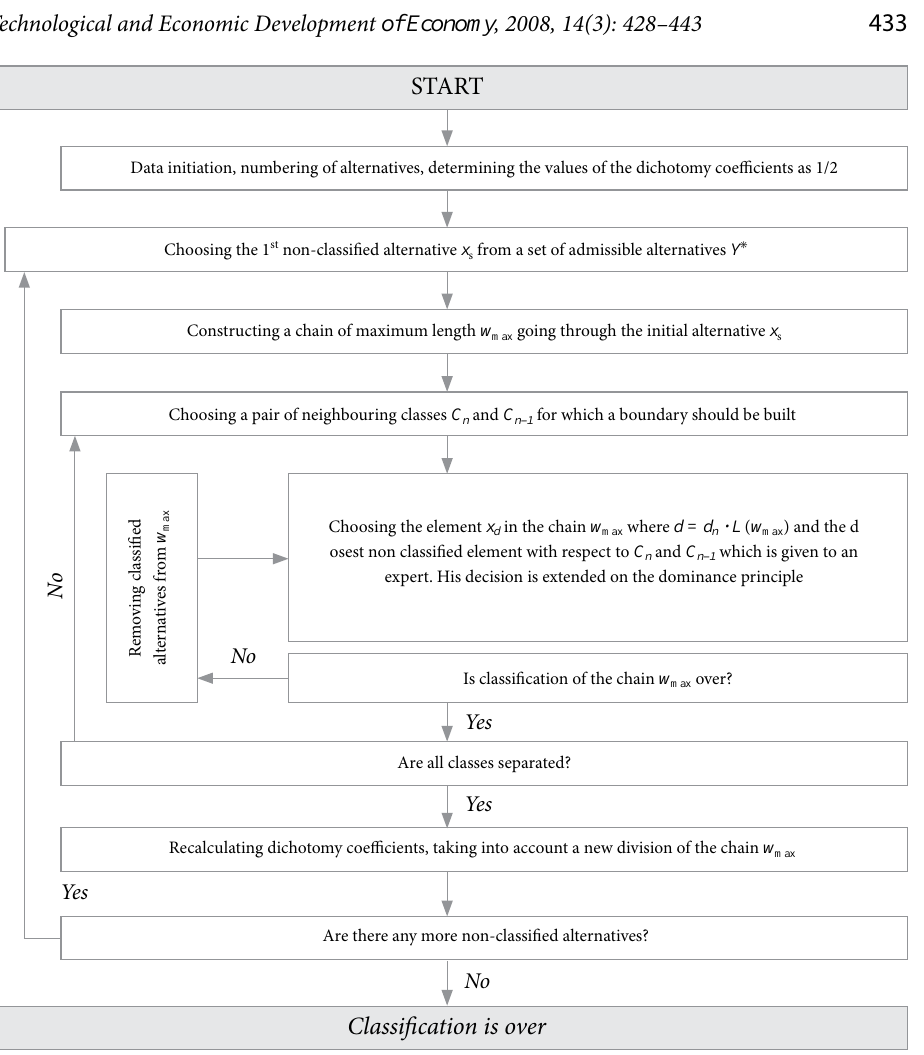
Fig. 1. A general block-diagram of the algorithm